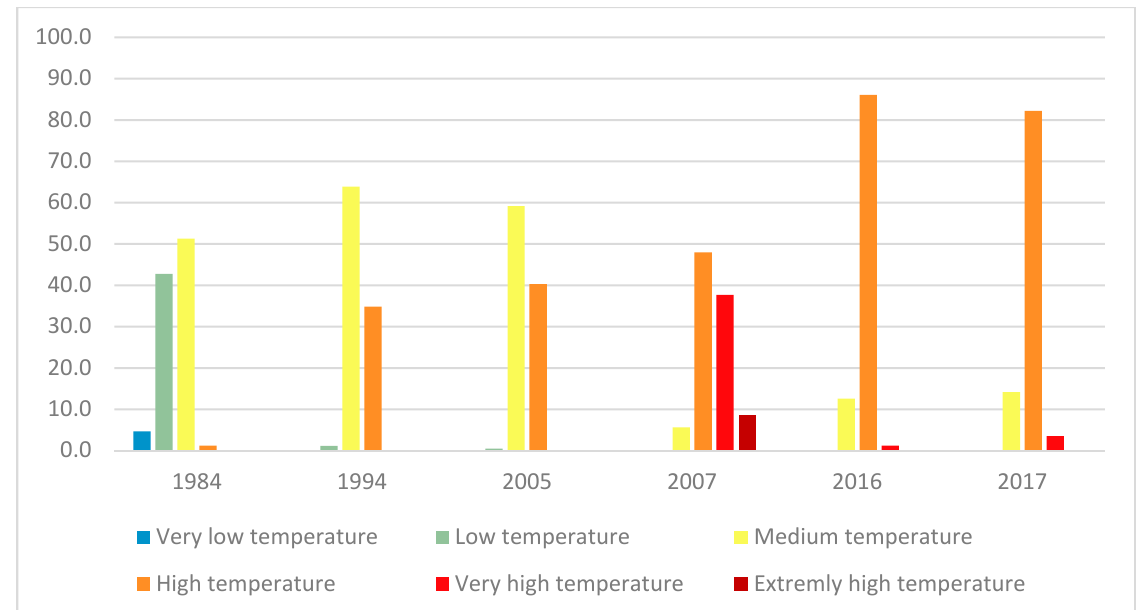
Figure 9. Evolution of different land surface temperatures between 1984 and 2017.